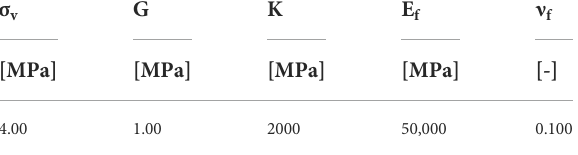
height ( t r ) are obtained. Each bearing is loaded in fi ve different horizontal directions, de fi ned by the fi ve angles ( ϑ ) listed in Table 1 and computed counterclockwise from the X axis (Figure 1B). Combination of the variable parameters leads to a total number of 240 Finite Element Models (FEMs), as part of the set presented in (Galano et al., 2021).